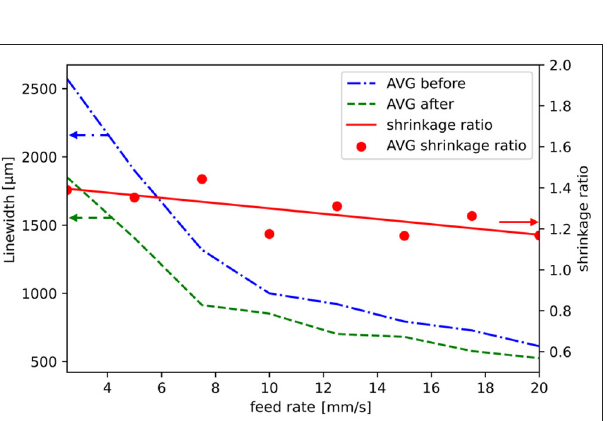
FIGURE 6 | (A) Image of the coated test substrate with different feed rates after the lift-off process. The different feed rates are written above the lines. The image was post-processed by increasing the brightness to get a better edge contrast. (B) The measured line width at a feed rate of 12.5 mm/s, before the metallization and the same line after (C) the lift-off. The pink dashed lines in (B) were post-processed to visualize the edge of the gelling sugar.